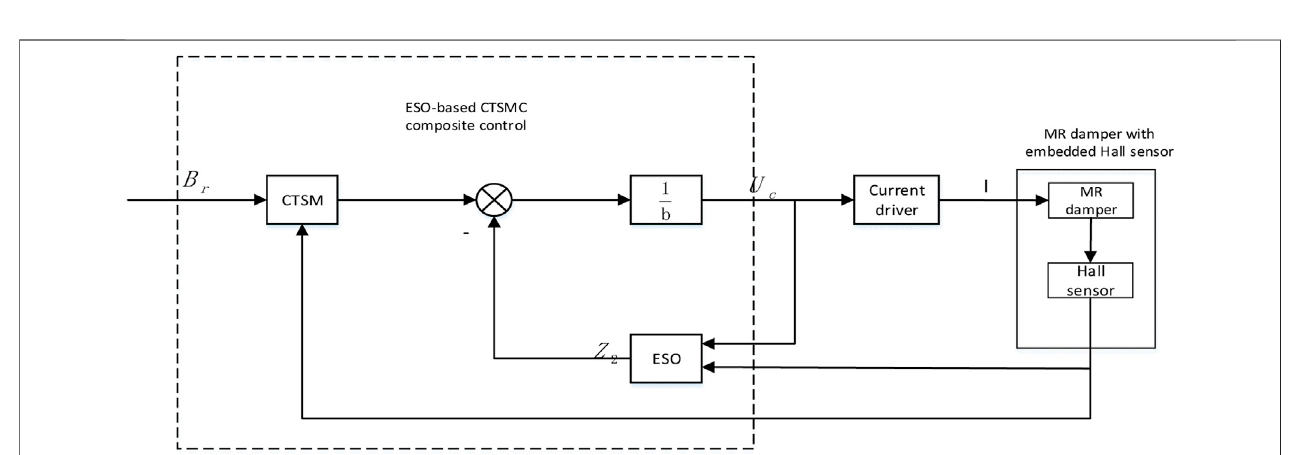
FIGURE 10 | Control schematic diagram of the sliding ADRC (CTSMC + ESO).